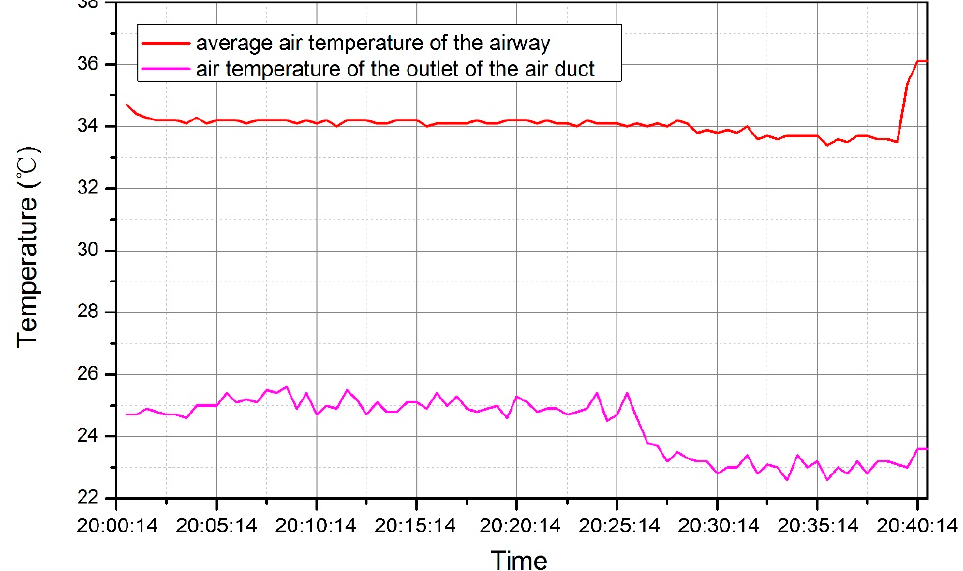
Figure 5. Measuring result of the variation of air temperature with time before 20:40.